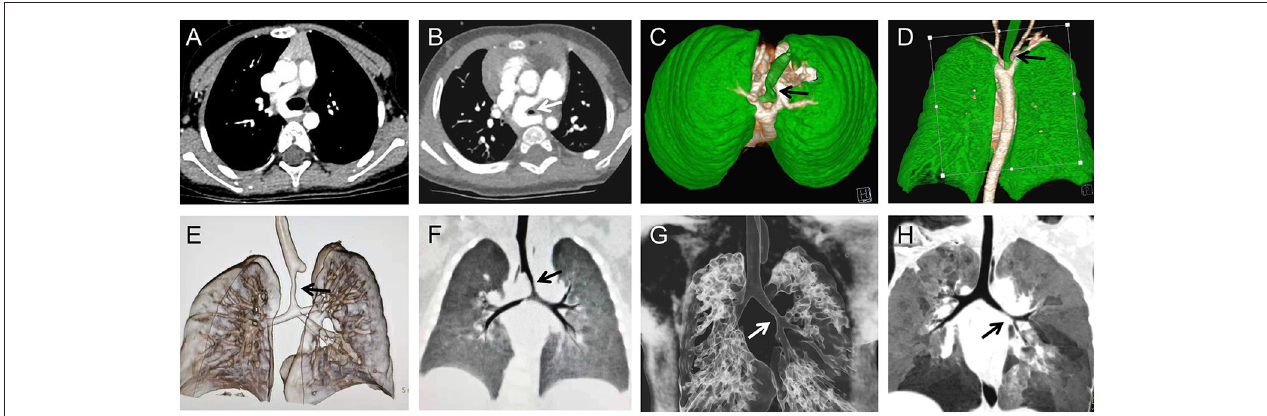
FIGURE 1 | Pulmonary CT and three-dimensional reconstruction of the airway, preoperatively showing the airway stenosis (arrows) was caused by pulmonary artery sling (A,B) , double aortic arch (C,D) , and a representative image of the stenosis (arrows) located in the trachea (E,F) and bronchus (G,H)